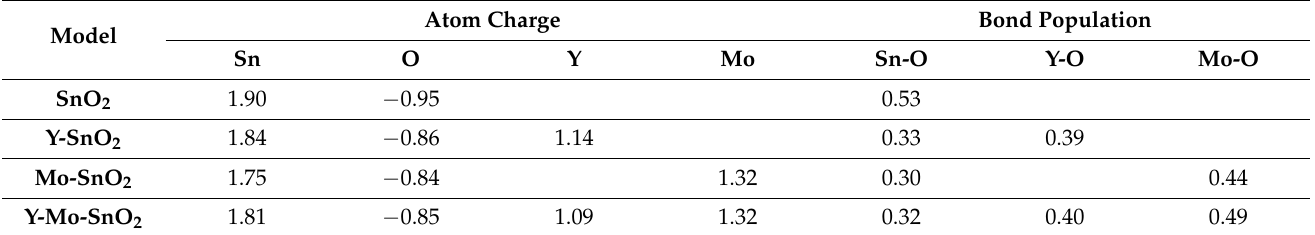
Table 4. Mulliken charge populations and bond